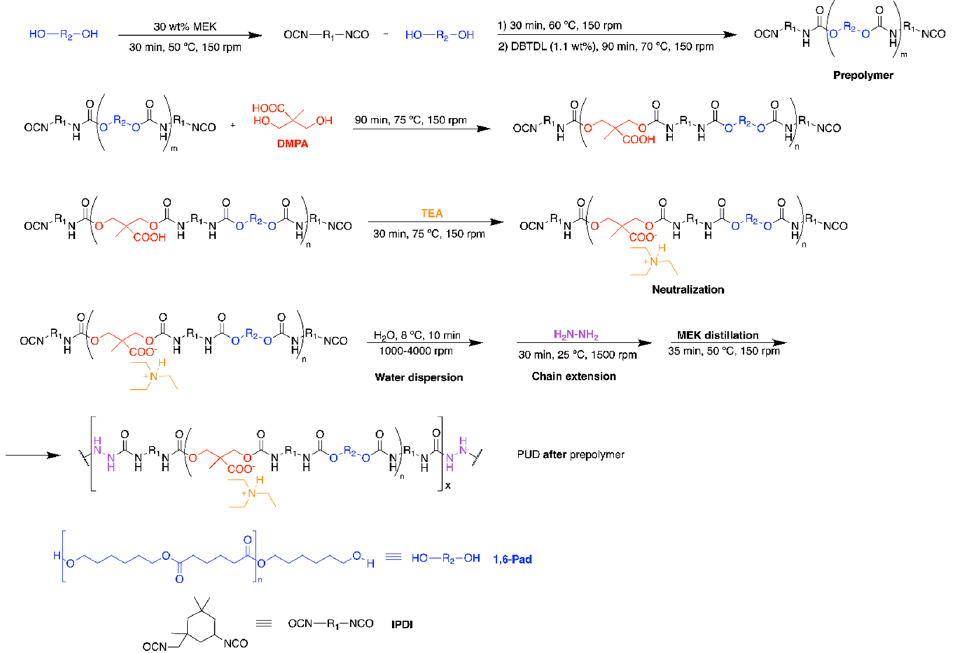
Figure 3. Synthesis of the PUD by adding DMPA after prepolymer formation.